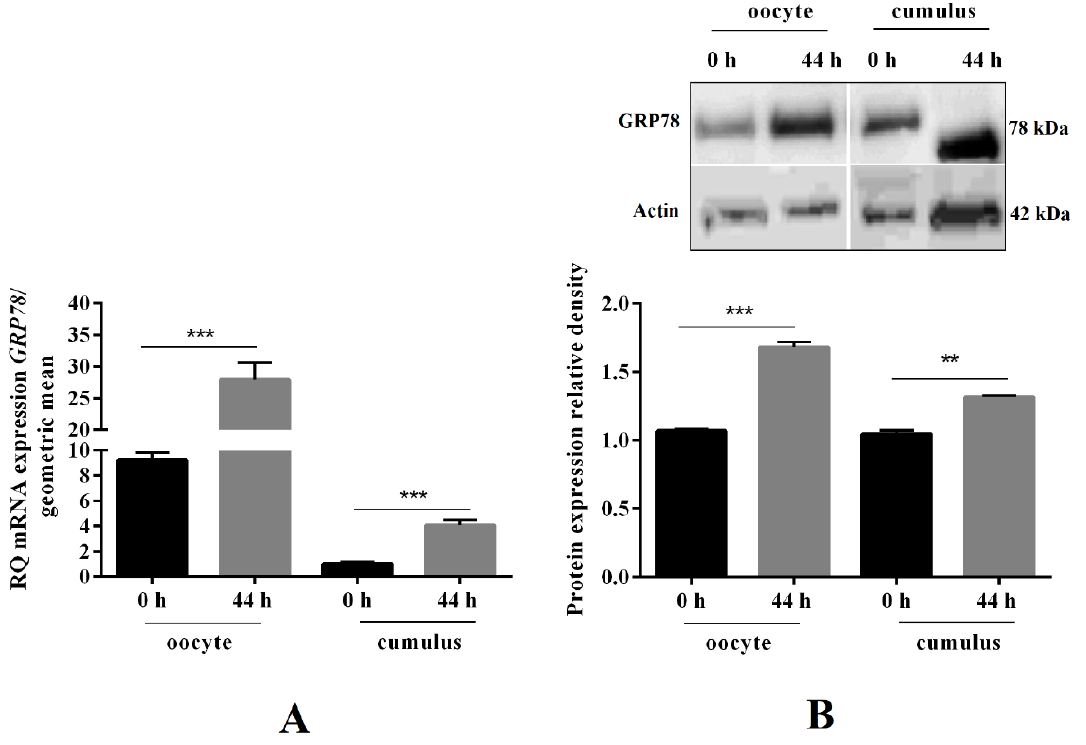
Figure 1. Vaspin mRNA and protein expression before and after oocyte in vitro maturation, as well as its immunolocalisation in cumulus–oocyte complexes (COCs). COCs (50/group/experiment) were selected after morphological examination of material collected from the ovaries taken from 100 pigs (15 follicles/ovary). COCs were collected before (0 h) and after (44 h) in vitro maturation and oocytes were denuded by gently pipetting in hyaluronidase, then real-time PCR and Western blot analysis were performed to determine mRNA ( A ) and protein ( B ) level of vaspin in oocytes and cumulus cells. Additionally, immunolocalisation of vaspin was analysed by immunofluorescence in COCs ( C ). Gene expression level was normalised to the geometric mean of actin and glyceraldehyde 3-phosphate dehydrogenase (GAPDH), and protein to actin. Vaspin immunostaining shown by arrows. Experiments were performed independently and repeated three times ( n = 3 ). The data are plotted as the mean ± standard error of the mean (SEM) of three independent experiments. Significance between groups before and after maturation is indicated by *** p < 0.001; Cumulus cells (Cc), oocyte (Oo), Immunoglobulin G (IgG).